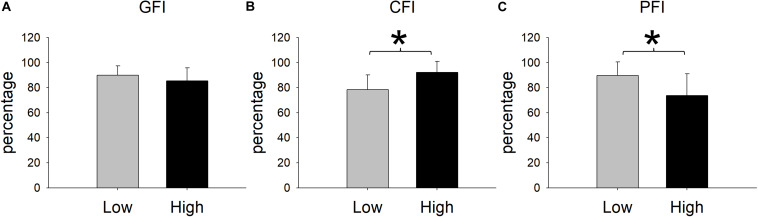
Cycling-induced fatigue indices in the two resistances. CFI represents central fatigue index; PFI represents peripheral fatigue index; and GFI represents general fatigue index. *Significant between low and relatively high resistance cycling exercise (P < 0.05).